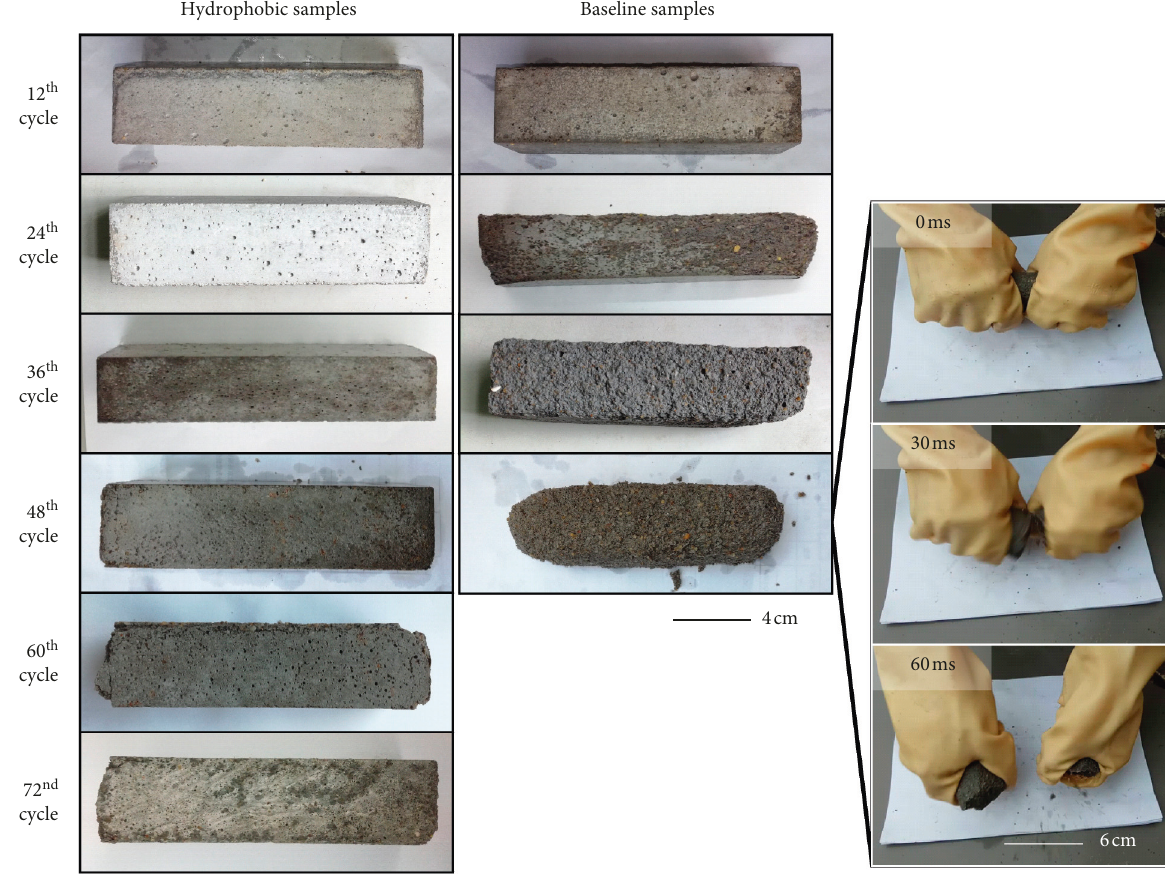
Figure 10: Photographs of the sample after different FTC tests.